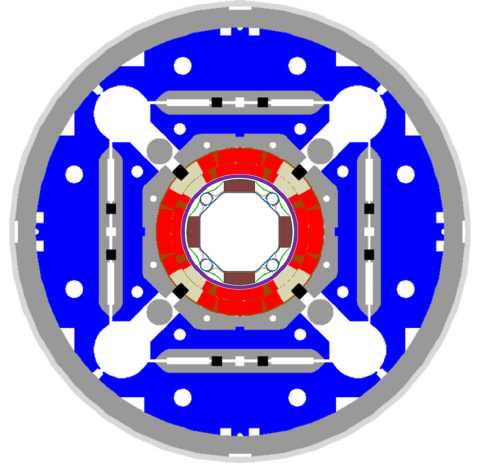
FIG. 2. The new Q1 HL-LHC beam screen inserted in the MQXF magnet. Q2, Q3 magnets have the same cross section but are equipped with a larger beam screen. The red area represents the coils and the beam screen is placed in the aperture surrounded by the cold